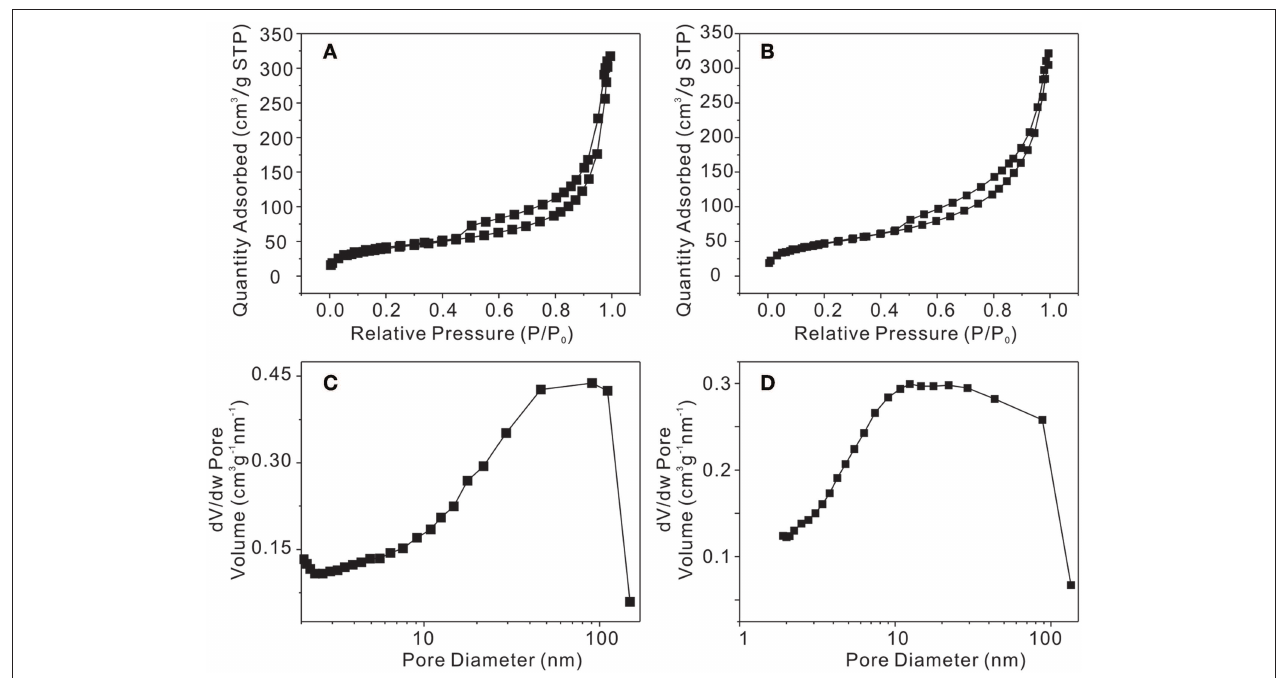
FIGURE 5 | Nitrogen adsorption/desorption isotherm (A) γ -AlOOH and (B) γ -AlOOH/Fe(OH) 3 , BJH pore size distribution plot of (C) γ -AlOOH and (D) γ -AlOOH/Fe(OH) 3 micro/nanoflowers.